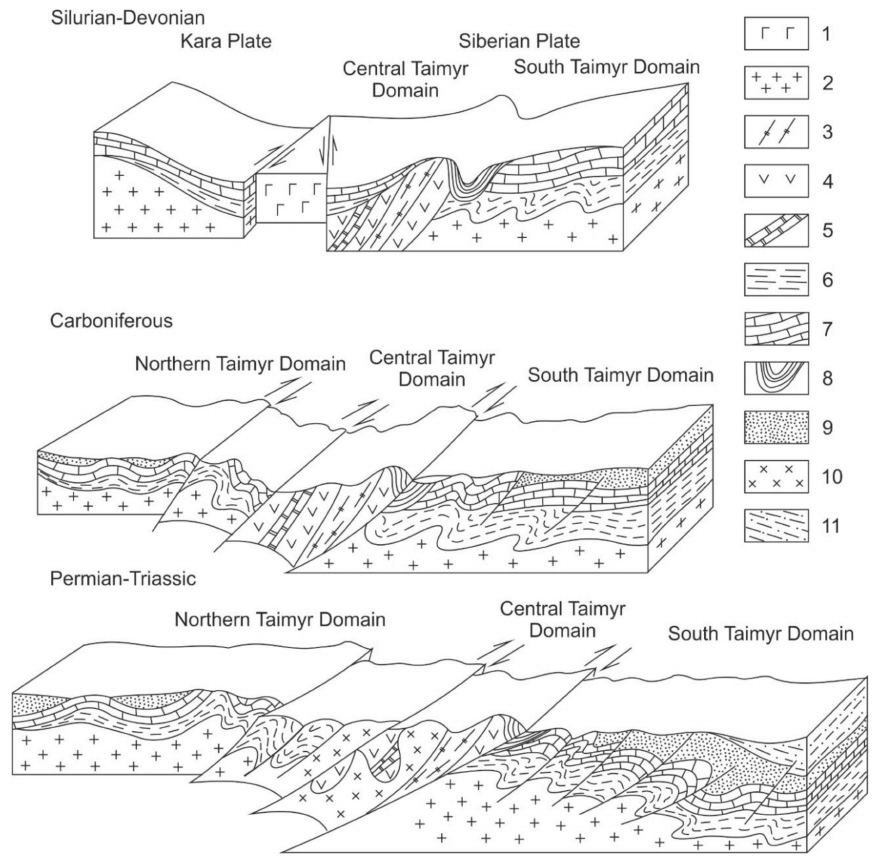
Figure 7. Model of transformation of the Taimyr margin of Siberia during interaction with the Kara microcontinent (Reference [54] with alterations). Composed based of sections of the Taimyr fold-and-thrust system [6], not to scale. 1—oceanic complexes; 2—early Precambrian complexes of the Kara microcontinent and Siberian craton crystalline basement; 3–5—late Precambrian complexes of the Central Taimyr accretionary zone: 3—gneiss, 4—volcanogenic-sedimentary, 6—Neoproterozoic-Cambrian flyschoid deposits of the Kara and Siberian continental margins; 7—Paleozoic mainly carbonate deposits of the shelf (Ordovician-Silurian on the Kara microcontinent and Ordovician-early Carboniferous on the Taimyr margin of the Siberian continent); 8—Ediacaran—early Carboniferous argillaceous-carbonate and black shales deposits of the Pyasina-Faddey deep-water basin; 9—late Paleozoic mainly terrigenous deposits (Devonian and Carboniferous–Permian for the Kara part and late Carboniferous–Permian of Southern Taimyr);